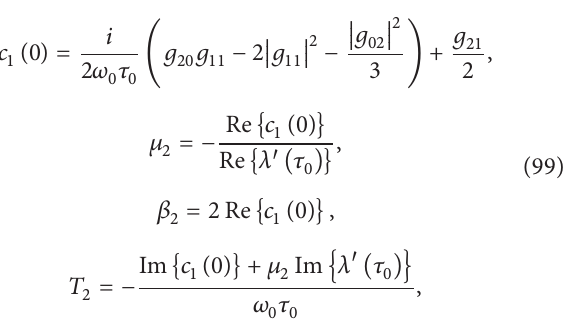
Figure 3: Phase plot for 𝑥(𝑡) - 𝑞(𝑡) with 𝜏 = 0.200